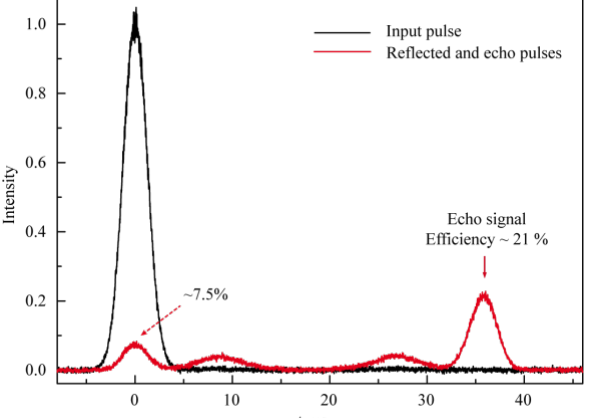
Fig 1. The signal of the revived silenced echo obtained by using Tm 3+ :Y 3 Al 5 O 12 crystal in impedance matched optical cavity. The signals from scattered π -pulses (red curve) can be seen between the input pulse and echo signal. The echo signal efficiency was 21% with storage time 36